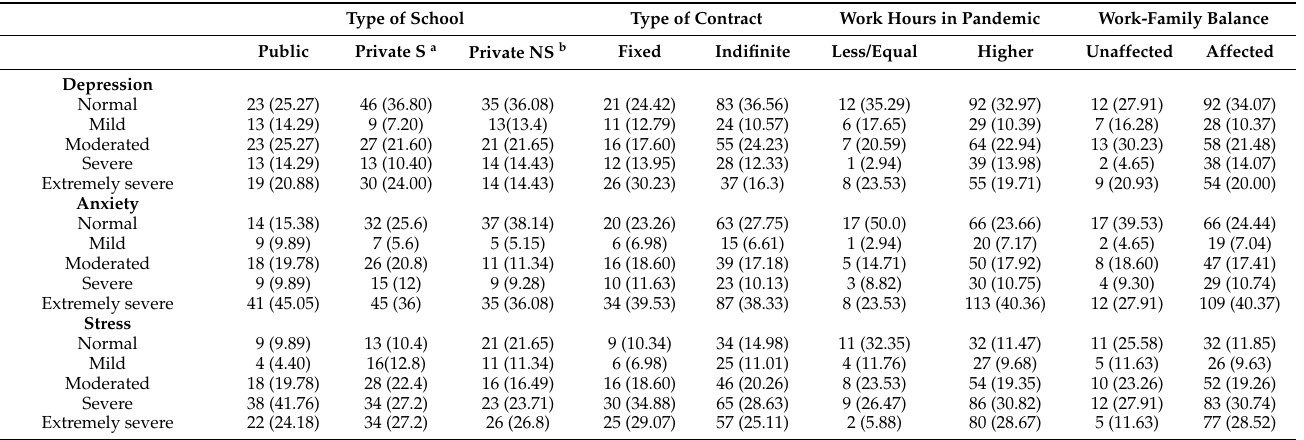
Table 4. Distribution of teachers with different symptomatology (mild, moderate, severe, and extremely severe) according to socio-personal